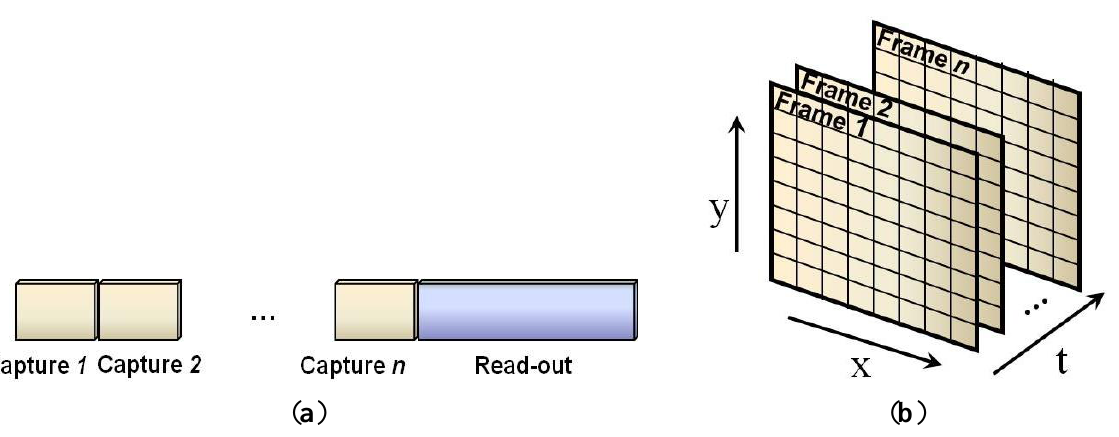
Figure 9. ( a ) Multiple-capture and one read-out timing diagram; ( b ) Cube of data for n